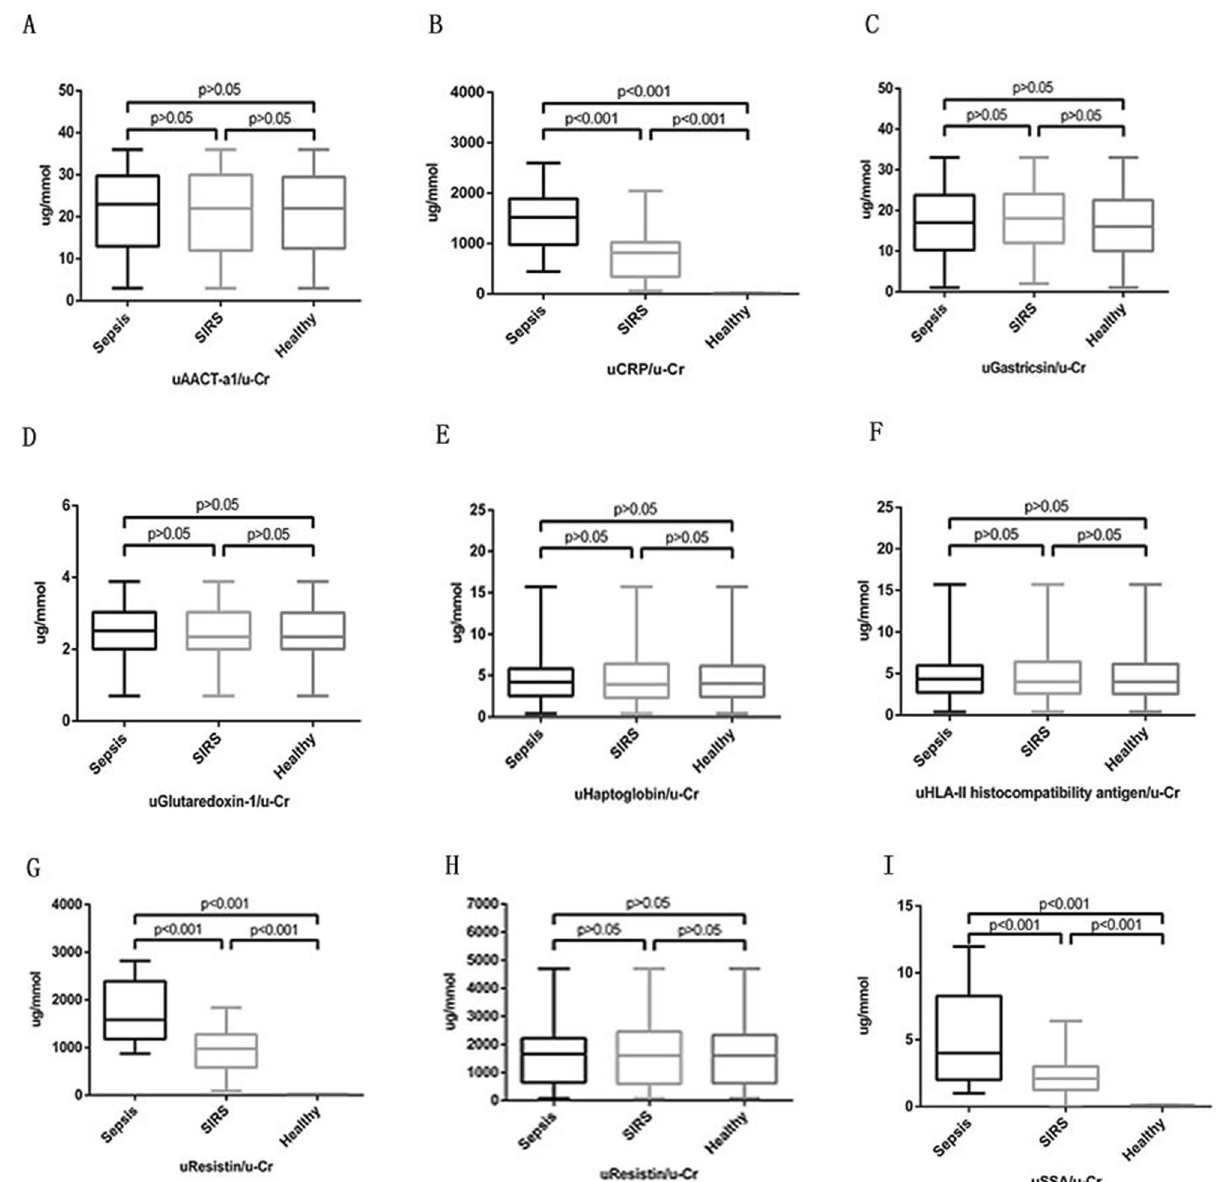
Figure 2. Box plot of adjusted concentrations.